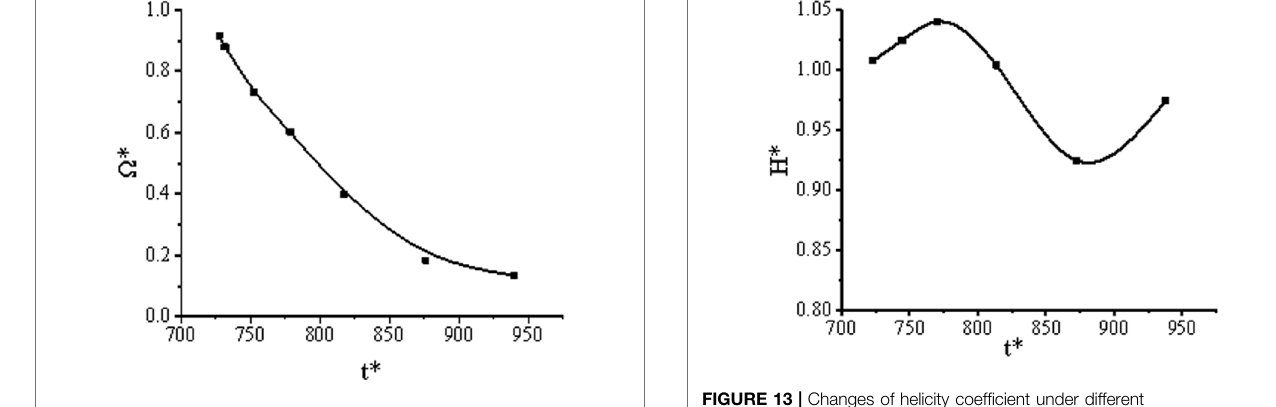
FIGURE 11 | Variations of vorticity coef fi cients under different formation times.